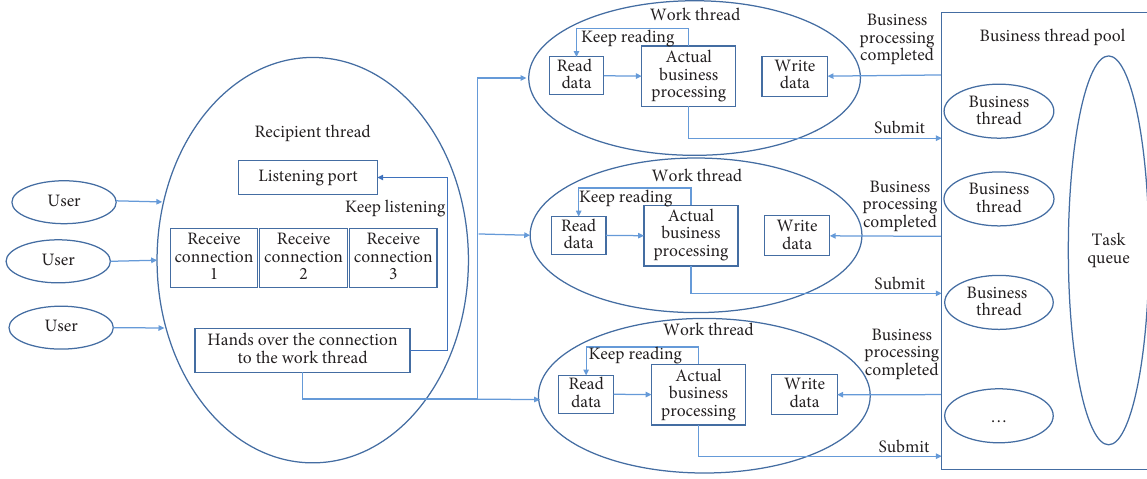
Figure 5: Thread model of application